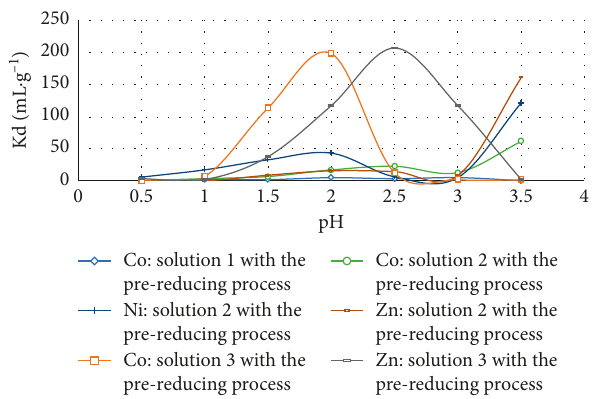
Figure 7: Coefficient distribution of copper, nickel, cobalt, and zinc with the pre-reducing